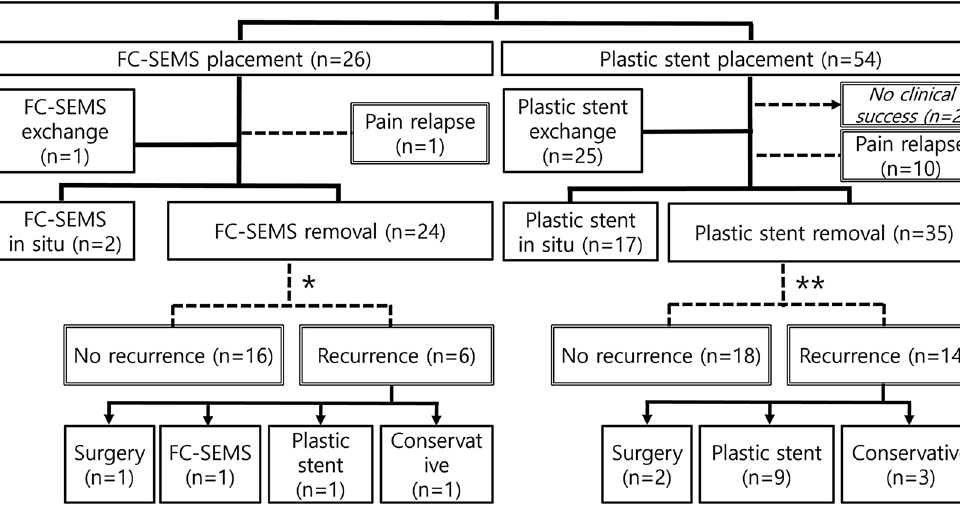
Figure 2. Flowchart for clinical outcomes. Exclusion of patients with failure of additional stenting of remained stricture (*n = 2; **n = 3). Abbreviations: FC-SEMS, fully covered self-expandable metal stent; MPD, main pancreatic duct.